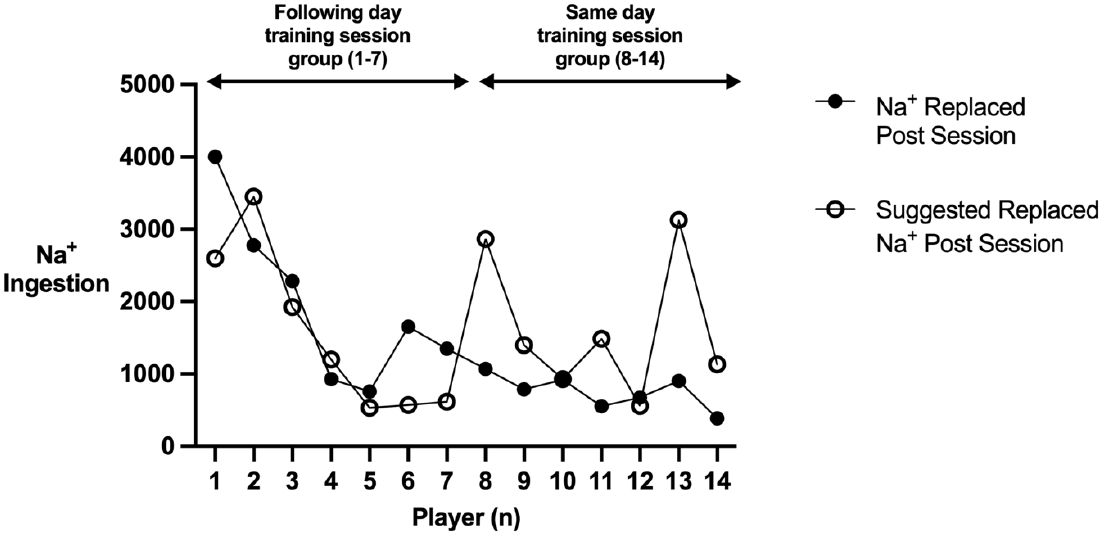
Figure 6. Players post session Na + ingestion in relation to their suggested post session Na + ingestion.